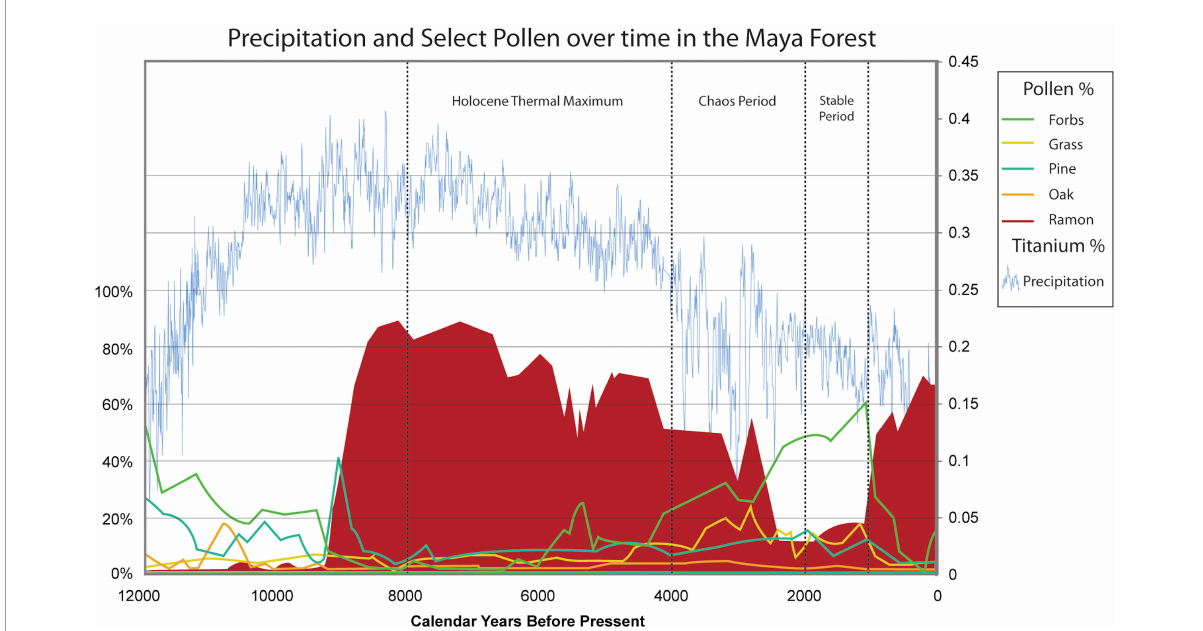
FIGURE3 Precipitation proxy and key pollen over 12,000 years in the Maya forest. Pollen data from Curtis et al. (1998), Brenner et al. (2002), and Leyden (2002) with Moracea-type, Brosimum alicastrum /Ramon as the indicator of forest, and the Cariaco Ti precipitation proxy data from Haug et al. (2003). Compiled by ISBER/MesoAmerican Research Center,